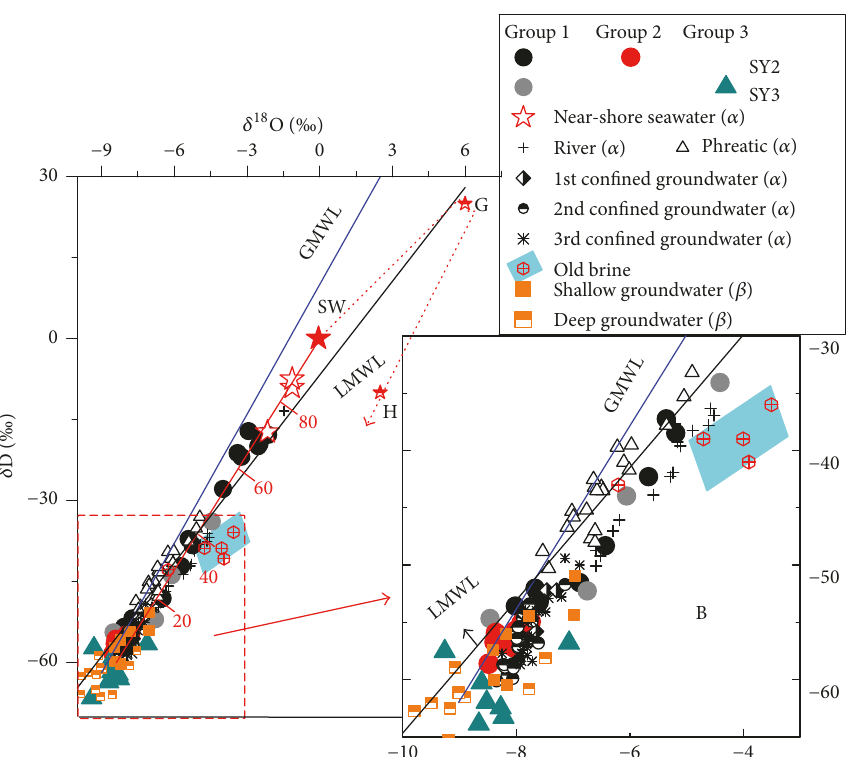
Figure 7: Plots of 𝛿 2 H versus 𝛿 18 O for porewater, aquifer groundwater, and river water samples. Samples with ( 𝛼 ) represent the water samples in the study area which were collected from Fu [22] based on aqueous analyses. Samples with (𝛽) represent aquifer groundwater samples in the Huai River basin that were obtained from Ha et al. [28]. The LMWL ( 𝛿 2 H = 5.8 𝛿 18 O-6.79) was plotted based on the 𝛿 18 O and 𝛿 2 H values of the average monthly rainfall at the nearest coastal station. The mixing line between the standard seawater and fresh aquifer groundwater ( 𝛿 2 H: − 60.1‰; 𝛿 18 O: − 8.4‰) is depicted in